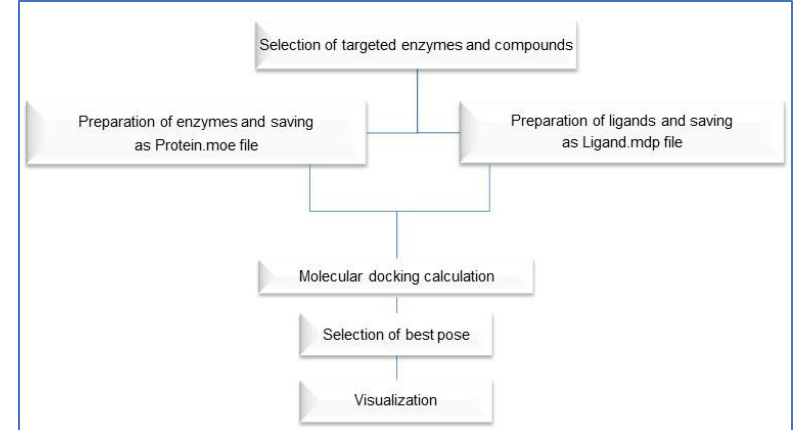
Figure 9. Flow chart of docking steps using MOE 2019.